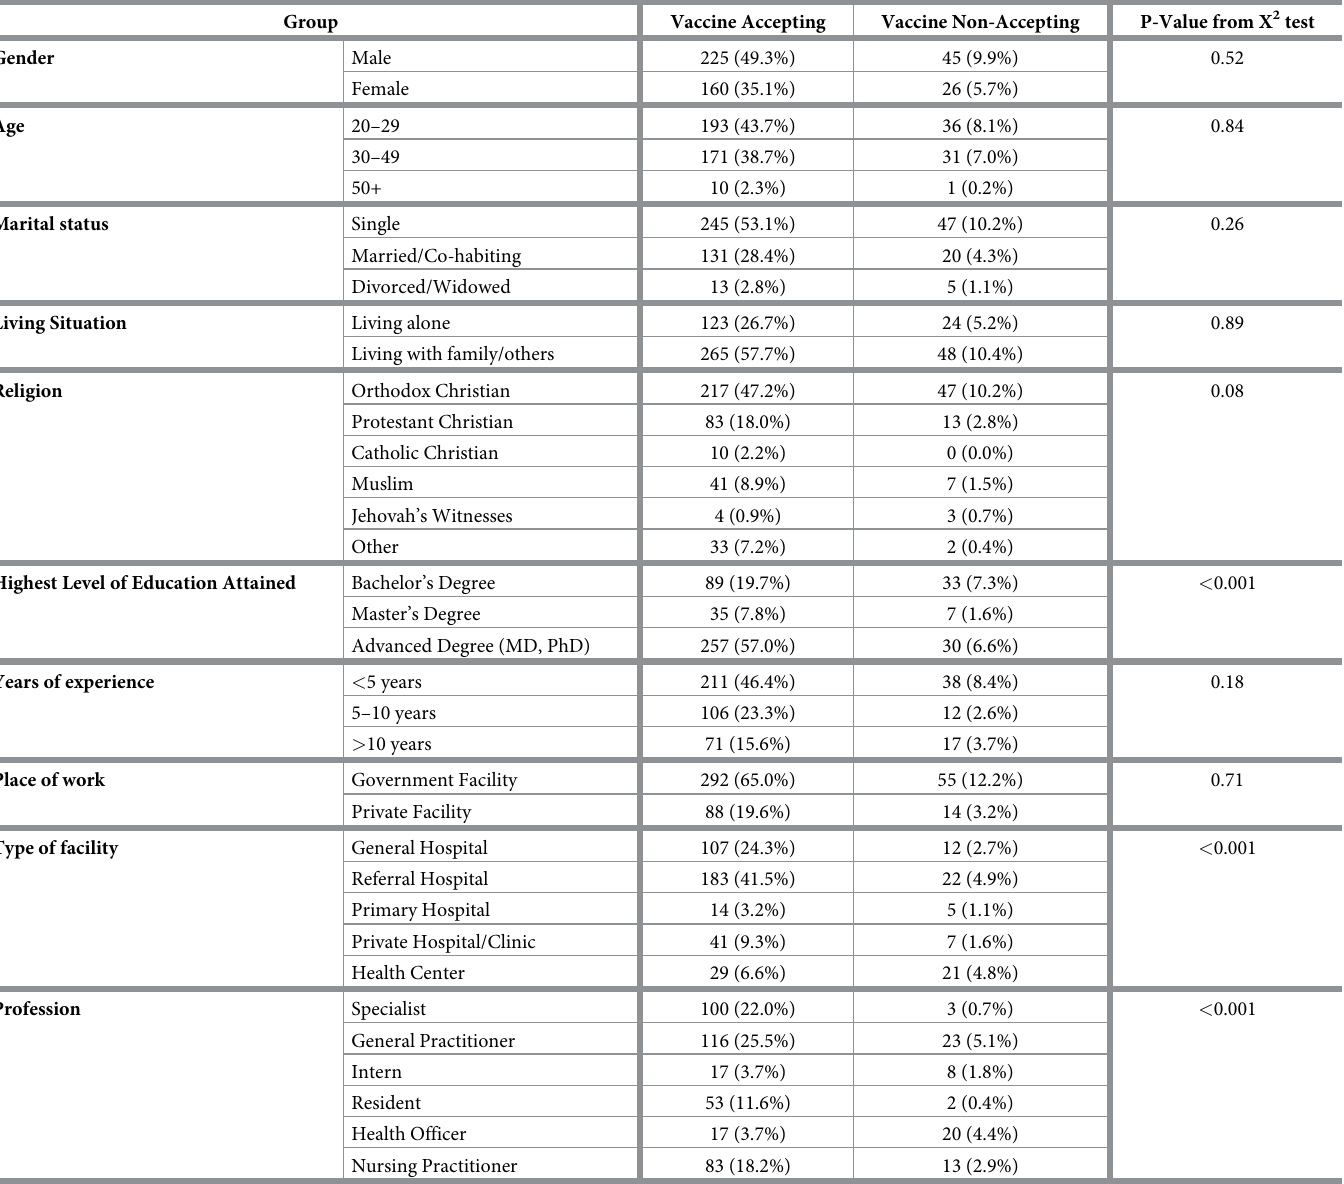
Table 2. Association data regarding the vaccine acceptance of the different demographic groups of our survey